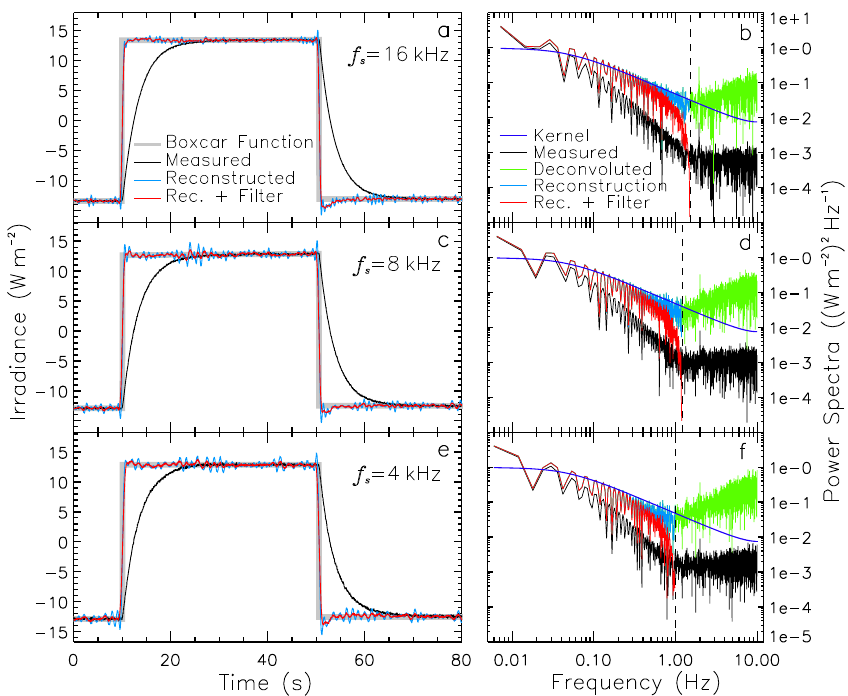
Figure 3. Measured (black) and reconstructed irradiance without filter (blue) and with filter (red) for an original boxcar function (gray) for three different sampling frequencies f s = 16/8/4kHz ( a , c and d ). The corresponding power spectra for the measured (black), deconvoluted (green) and reconstructed time series (blue and red) as well as the convolution kernel (dark blue) are given in ( b , d , and f